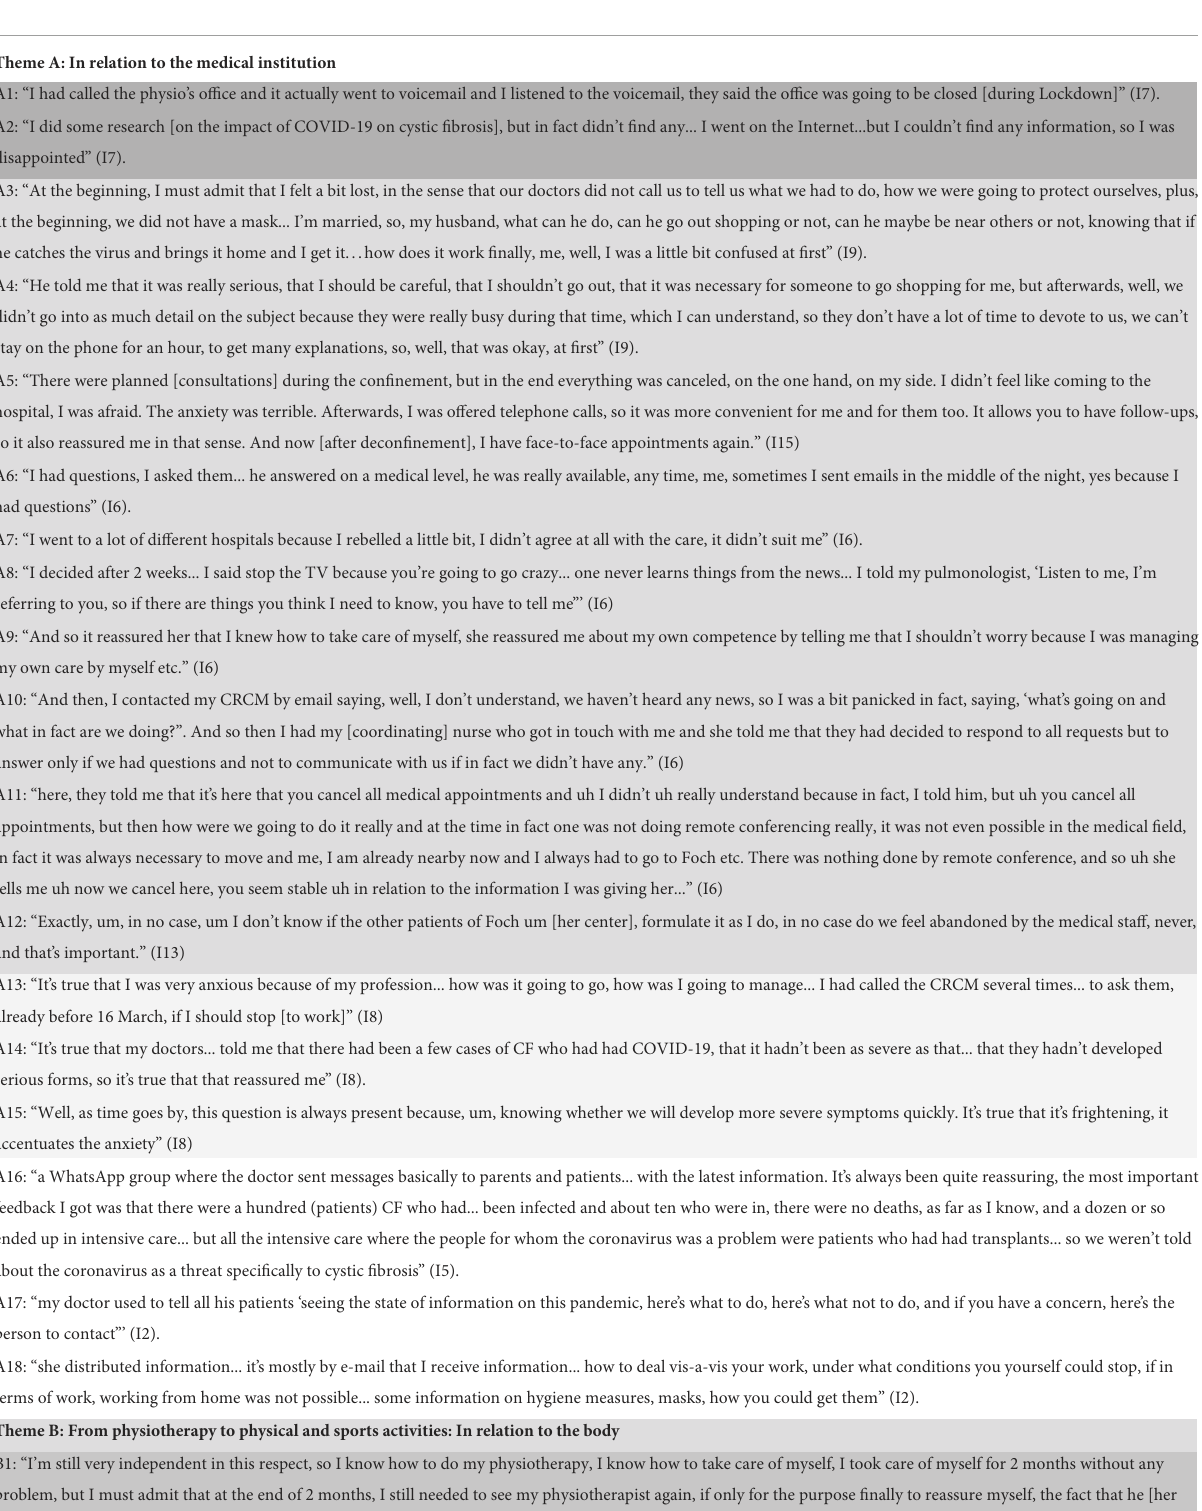
TABLE 3 Verbatim from 9 representative patient’s